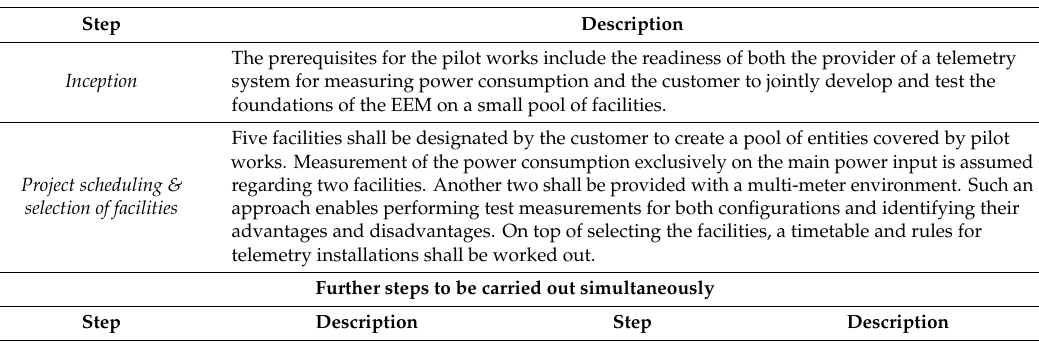
Figure 1. Reference process of a pilot energy efficiency management (EEM) implementation within a multi-facility organization. Table 1. Description of pilot EEM implementation reference process steps.